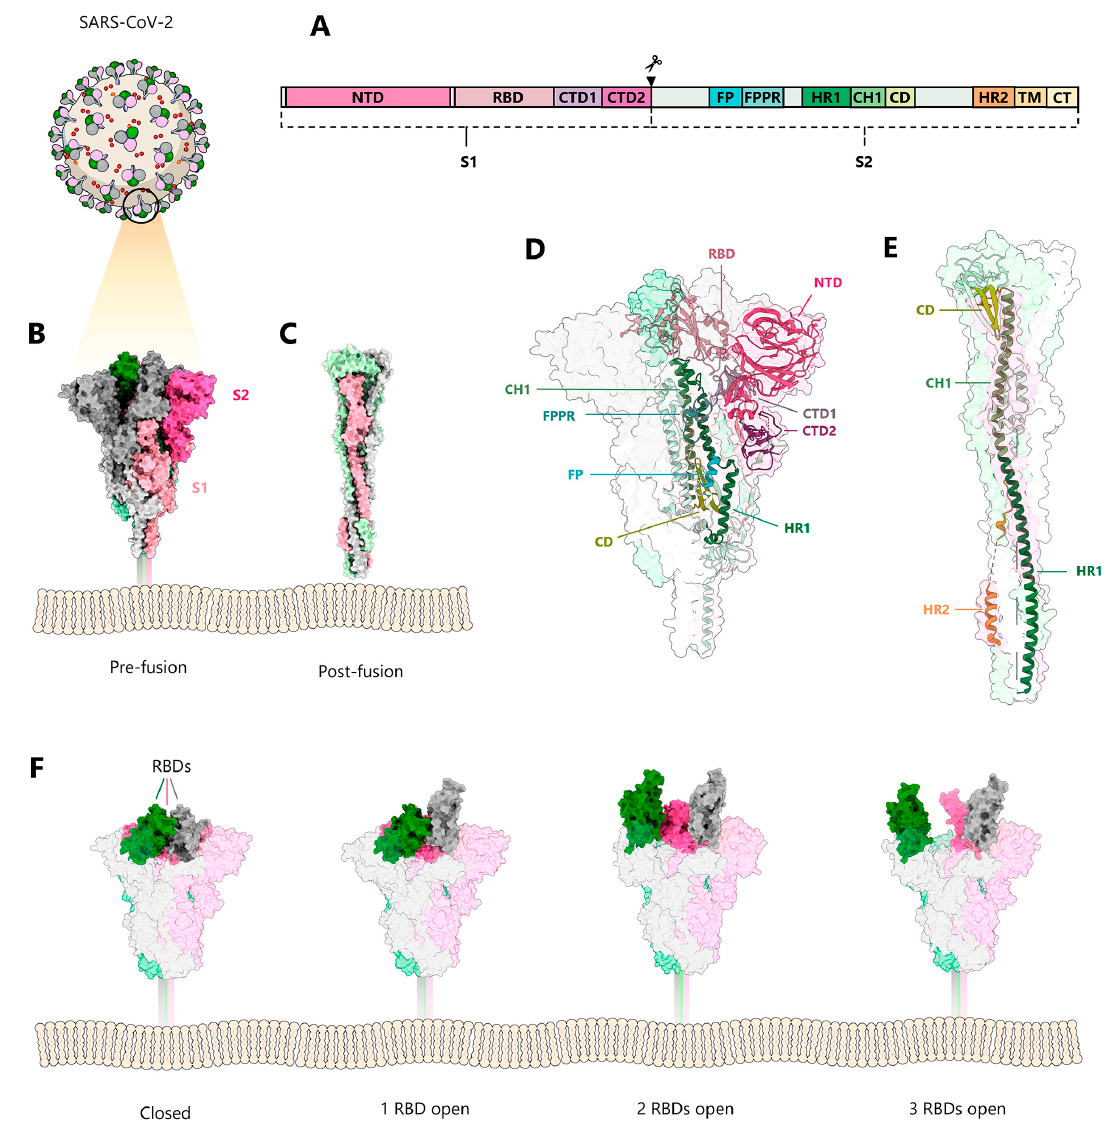
Figure 1. Conformations of the SARS-CoV-2 spike protein. ( A ) Model of SARS-CoV-2 and schematic representation of the domain structure of the spike glycoprotein S. ( B ) Side-view of the prefusion S trimer (PDB:6XR8) [35], showing the three protomers in grey, pink, and green, with the corresponding S1 subunits colored lighter than the S2 subunits. ( C ) Side-view of the post-fusion trimer (PDB:6XRA) [35]. ( D ) Side-view of the prefusion and ( E ) the post-fusion trimers shown as molecular envelope, with a single protomer illustrated as ribbon; the domains are colored as indicated in ( A ) (PDB:6XRA and 6XR8) [35]. ( F ) Conformational variability of RBDs in the prefusion spike; from left to right: closed (PDB: 6XRA) [35], one receptor-binding domain (RBD) in the up position (PDB: 7KRR) [48], two RBDs in the up position (PDB: 7EB5) [49], and three RBDs in the up position (PDB: 7KML) [50].